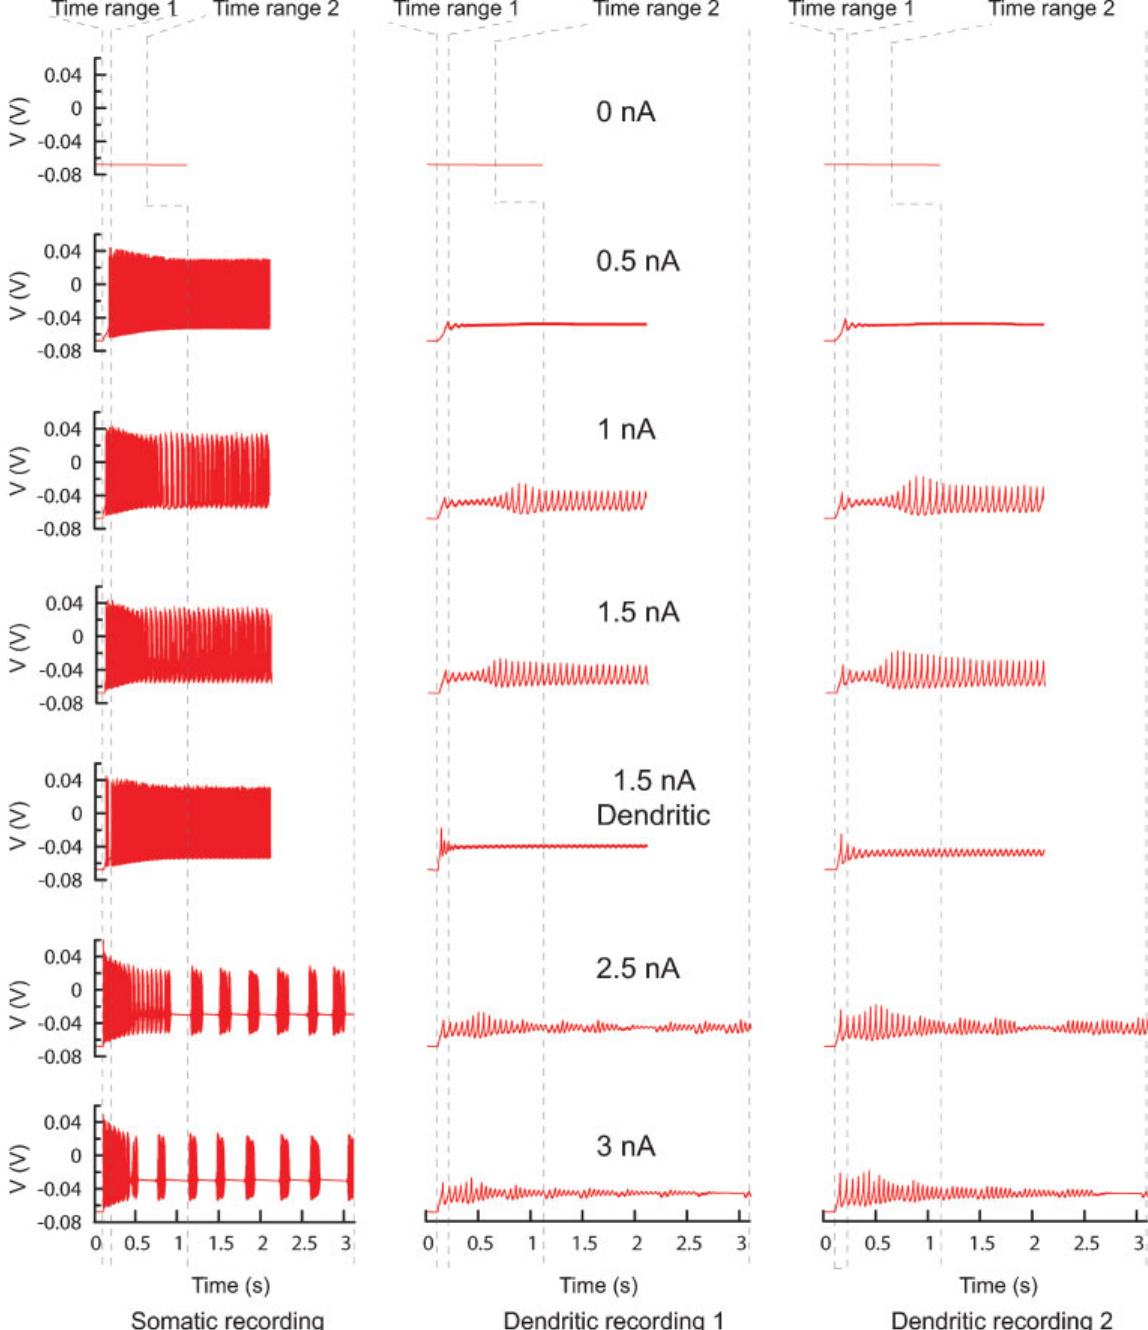
spiking frequencies, spike heights, spike widths, bursting frequencies, number of spikes per burst, etc. These properties are measured from the data and compared to similar measurements from the model to calcu- late the error. We have previously shown that our method achieves the same accuracy as these approaches (Achard and De Schutter, 2006, Sup- plementary data). This approach requires criteria to consistently define spikes, bursts, “regularly spiking”, etc. It necessitates the use of